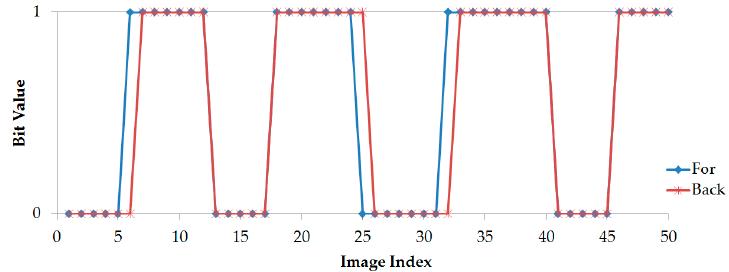
Figure 14. The experimental relation between the asynchronous bit of the forward part and the bit of the backward part. The packet rate at 5 packet/s is used for an illustrative graph.